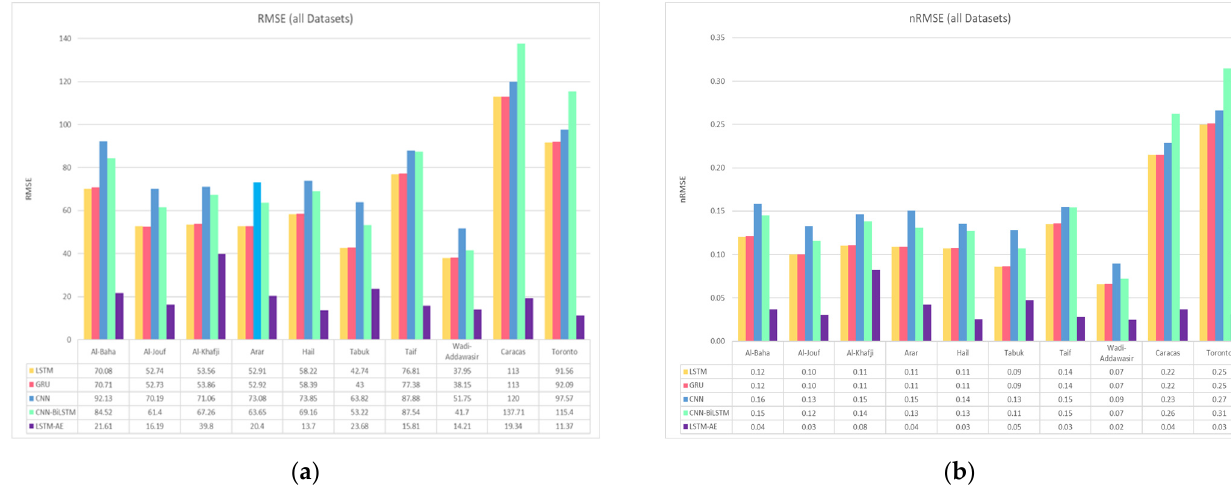
Figure 24. Forecasting results of 5 models for all datasets ( a ) RMSE; ( b ) nRMSE. Forecasting results using the MAPE metric and its normalized values are plotted in Figure 25. From the figure, we can see that the location effect on MAPE and nMAPE values are different from what was observed earlier with MAE and RMSE results. For example, the best nMAPE value for the LSTM model is 0.04 is achieved with Al-Baha, Tabuk, and Wadi-Addwasir, while for the GRU model it is also achieved 0.04 with Tabuk and Wadi-Addwasir. For the CNN model, the best nMAPE value is 0.13, achieved with Caracas. For the CNN-BiLSTM model, the best nMAPE value is 0.02, achieved with Tabuk and Wadi-Addwasir. For the LSTM-AE model, the best nMAPE value is 0.02, achieved with Hail, Taif, and Caracas. On the other hand, the worst values for all models are associated with Toronto, except for the LSTM-AE model, which has the worst value of 0.07 with Al-Khafji. Comparing the performance of the different models, the best is the LSTM-AE model for five datasets (Al-Baha, Hail, Taif, Caracas, Toronto) and the CNN-BiLSTM model for four datasets (Al-Khafji, Arar, Tabuk, Wadi-Addwasir). The worst is the CNN model for all locations. MAPE (refer to Equation (8)) is different from the other metrics because it gives the forecasting error relative to the actual GHI, which might explain the different results observed with this metric.